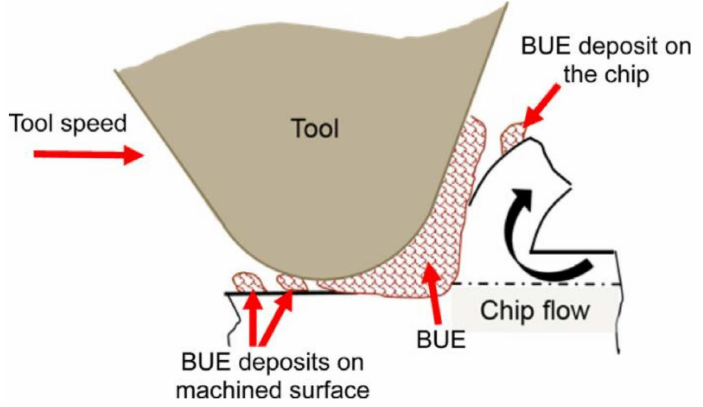
Figure 4. Schematic diagram of BUE formation in micromachining processes